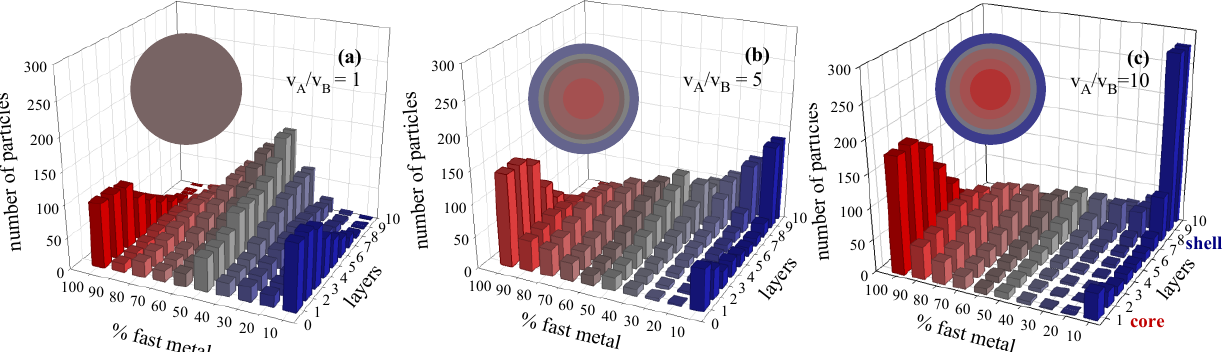
Figure 1. Histograms represent the number of particles with a given percentage of the faster metal A in each layer, from the nanoparticle core to the surface, for different values of reduction rate ratio. ( a ) v A /v B = 1; ( b ) v A /v B = 5; ( c ) v A /v B = 10). Synthesis conditions: film flexibility ( k ex = 5, f = 30) and metal salt concentration (  c  = 32 metal salts in a micelle). Scheme color: blue (0%–45% of A), grey (45%–55% of A), red (55%–100% of A). Less red means less A. Circles in each histogram represent the nanoparticle structure in concentric layers, keeping the same color